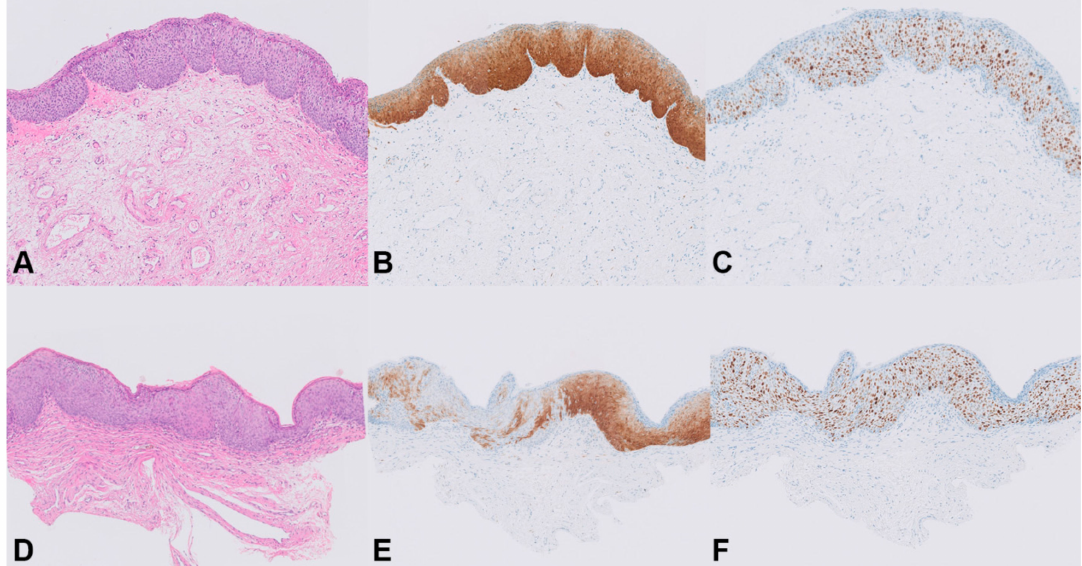
Figure 3. Staining patterns for p16 INK4a in HSIL. Patient 8, HSIL 1: ( A ) H&E stain (20 × ); ( B ) homogeneous p16 INK4a staining, score 3 (20 × ); ( C ) full-thickness immunostaining of Ki-67, score 3 (20 × ). Patient 8, HSIL 2: ( D ) H&E stain (20 × ); ( E ) combined diffuse and patchy p16 INK4a staining, score 2 (20 × ); ( F ) full-thickness immunostaining of Ki-67, score 3 (20 ×